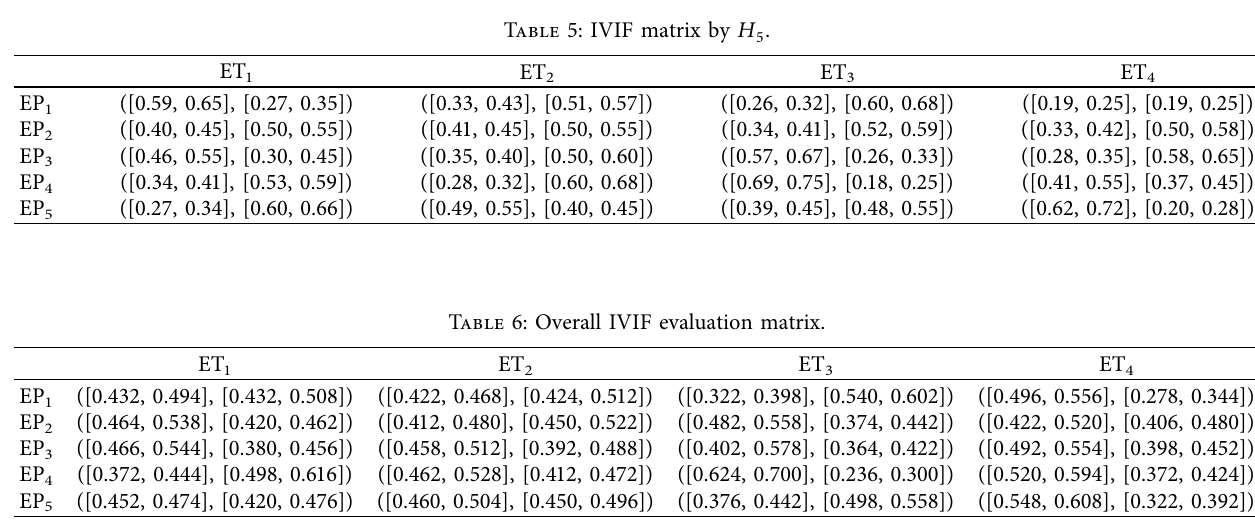
Table 5: IVIF matrix by H